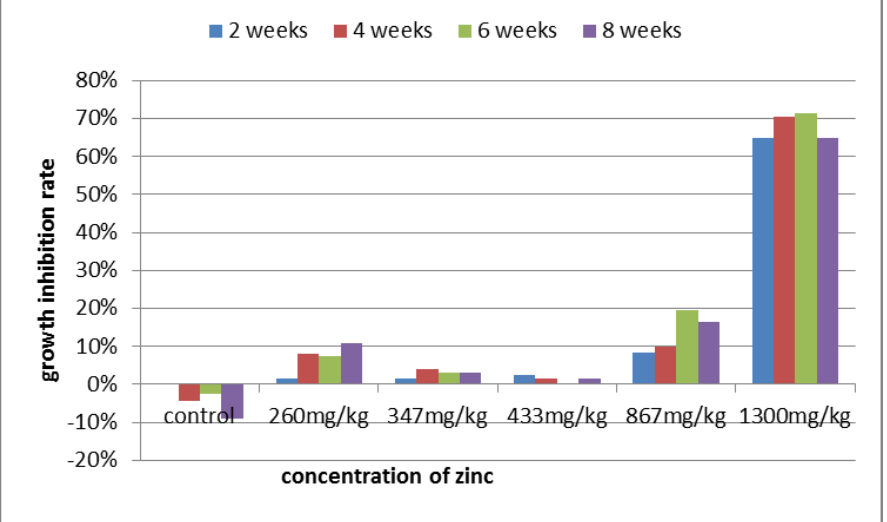
Figure 3. Growth inhibition rates of the juvenile earthworm Eisenia fetida after exposure to zinc under testing conditions.